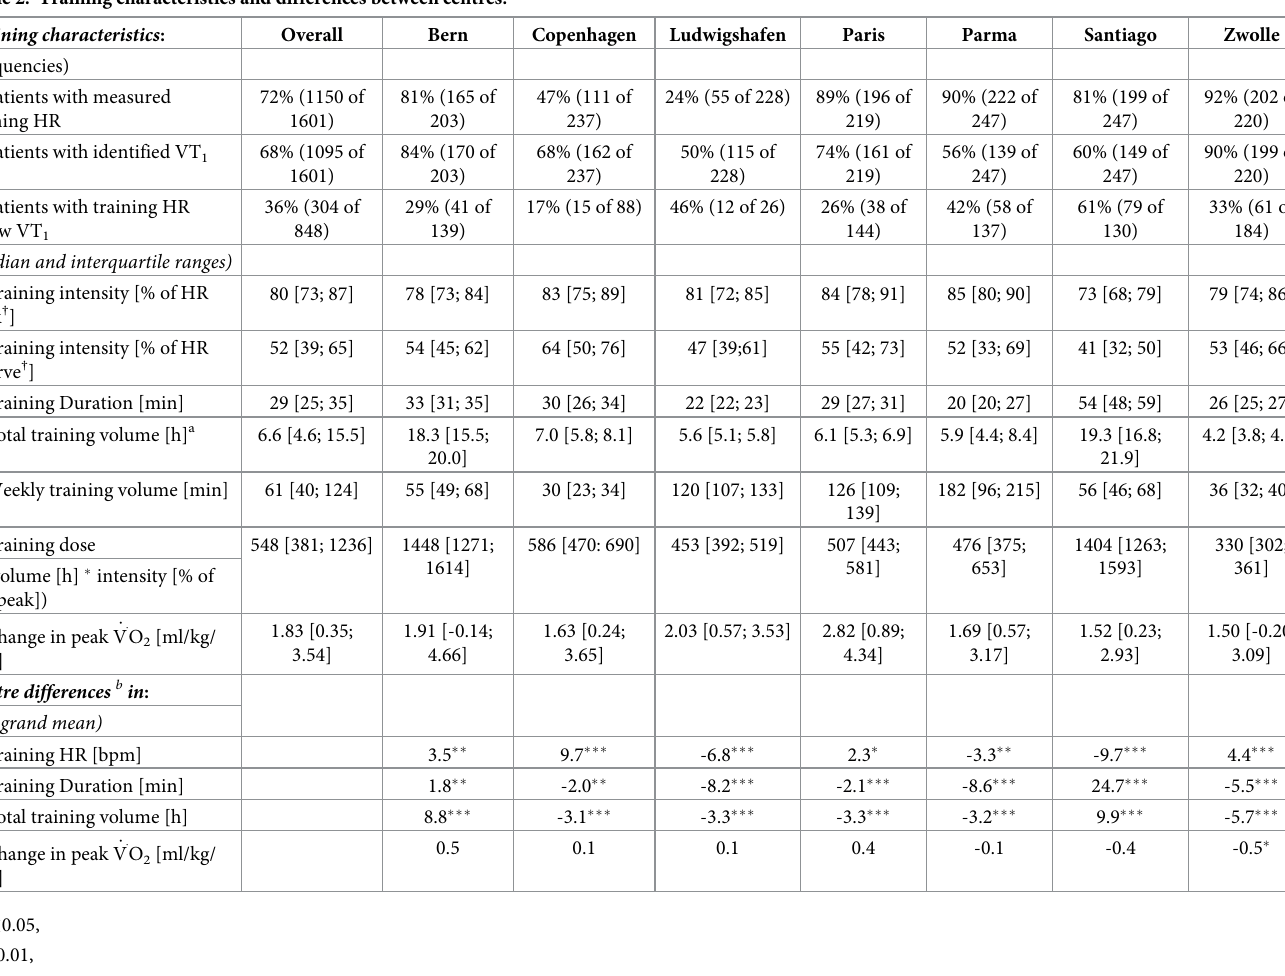
Table 2. Training characteristics and differences between centres. Training characteristics